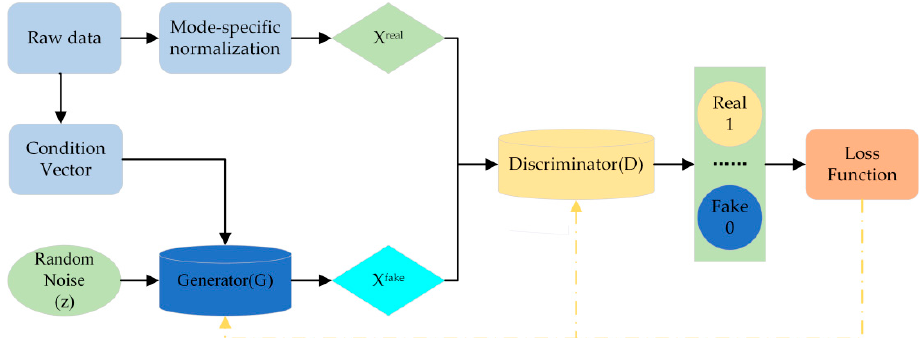
Figure 8. Basic structure of Conditional Tabular GAN (CTGAN) model.